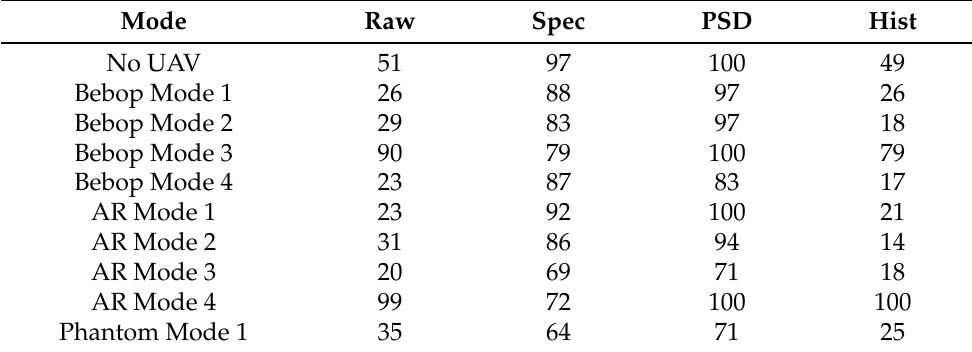
Table 3. Individual Classification LR F1-Score (%).